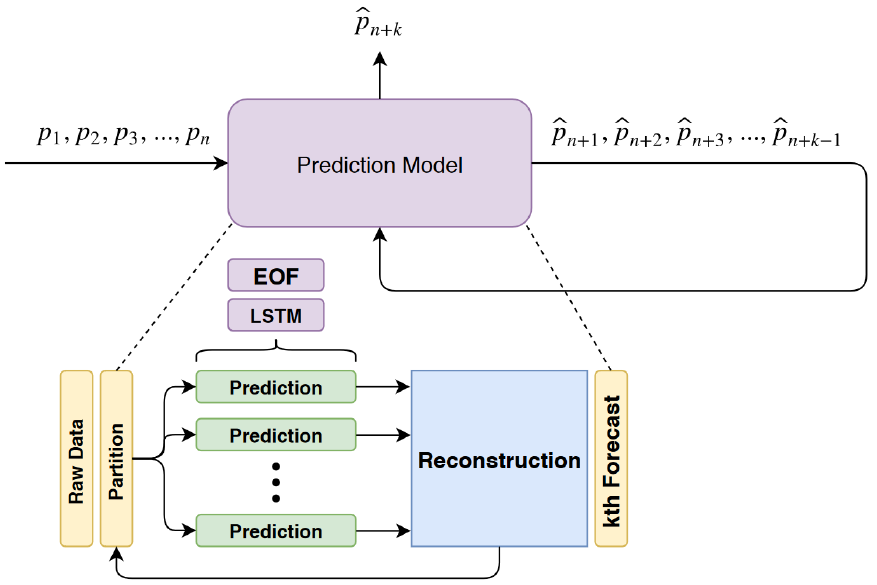
Figure 1. Flow chart of the recurrent learning algorithm used [4]. The figure above consists of two parts: the overarching abstract model and the implementation of the model with partitioning. The abstract model is essentially a dynamic prediction model, recursively predicting k steps ahead. The implementation detail shows the core components of the